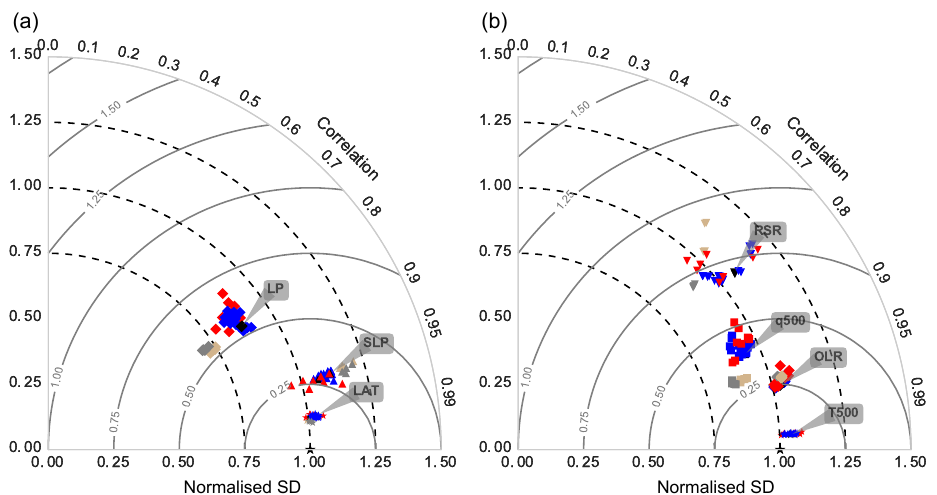
Figure 6. Normalised Taylor diagrams for land air temperature (asterisks), mean sea level pressure (triangles) and land precipitation (dia- monds) (a) as well as temperature at 500hPa (asterisks), OLR (diamonds), relative humidity at 500hPa (squares) and reflected shortwave radiation (inverted diamonds) (b) . Default HadAM3 (HadAM3P) values are gray (black). Independent 7-parameter and 14-parameter cases are shown in blue and red, respectively. The labels point to the standard HadAM3 values.